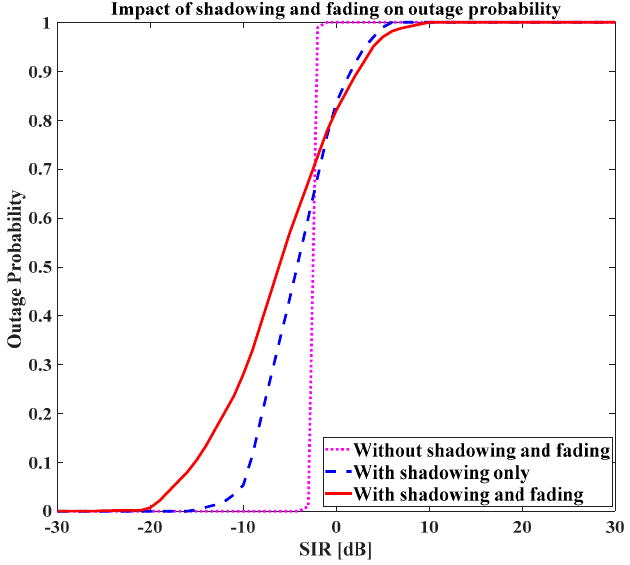
Figure 6. Outage probability as a function of SIR for the UE at the cell edge.